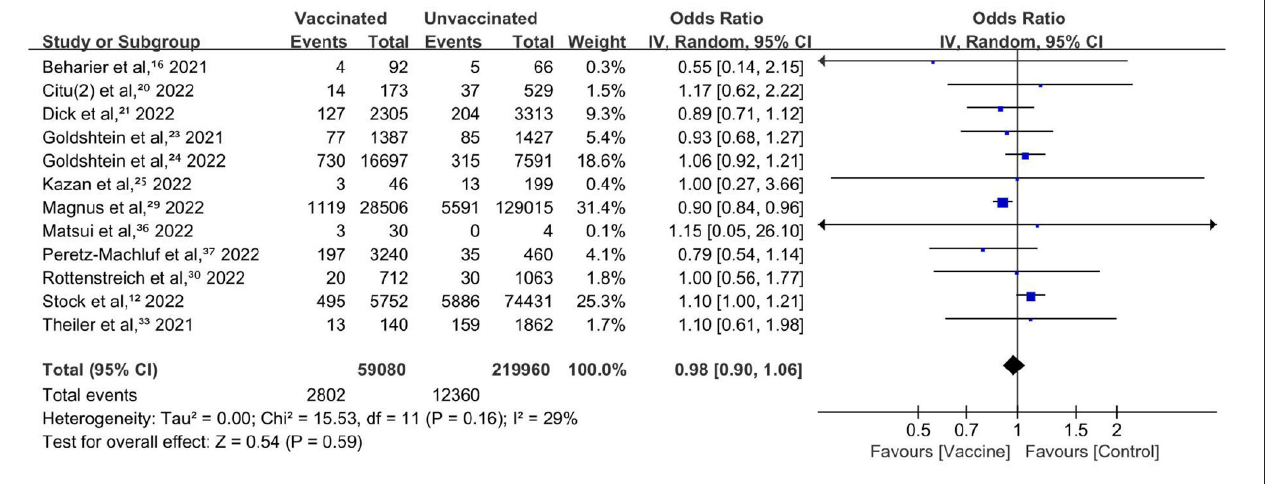
FIGURE3 Forest plot for preterm